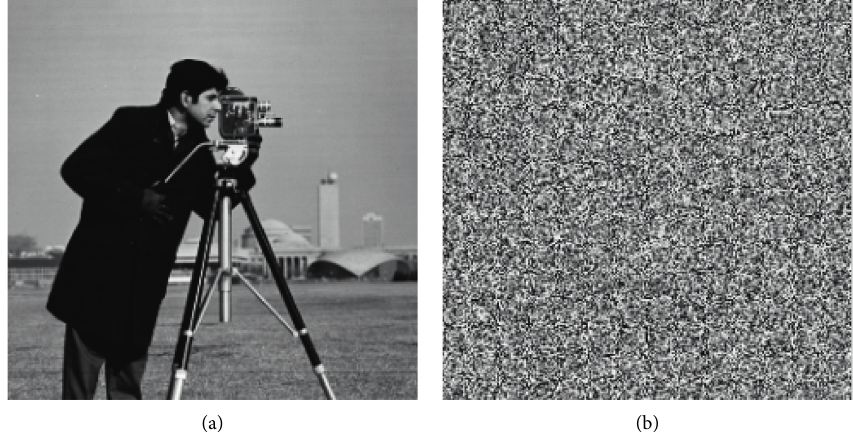
Figure 14: (a) Original image and (b) extracted image in the receiver with one wrong bit in the secret key.